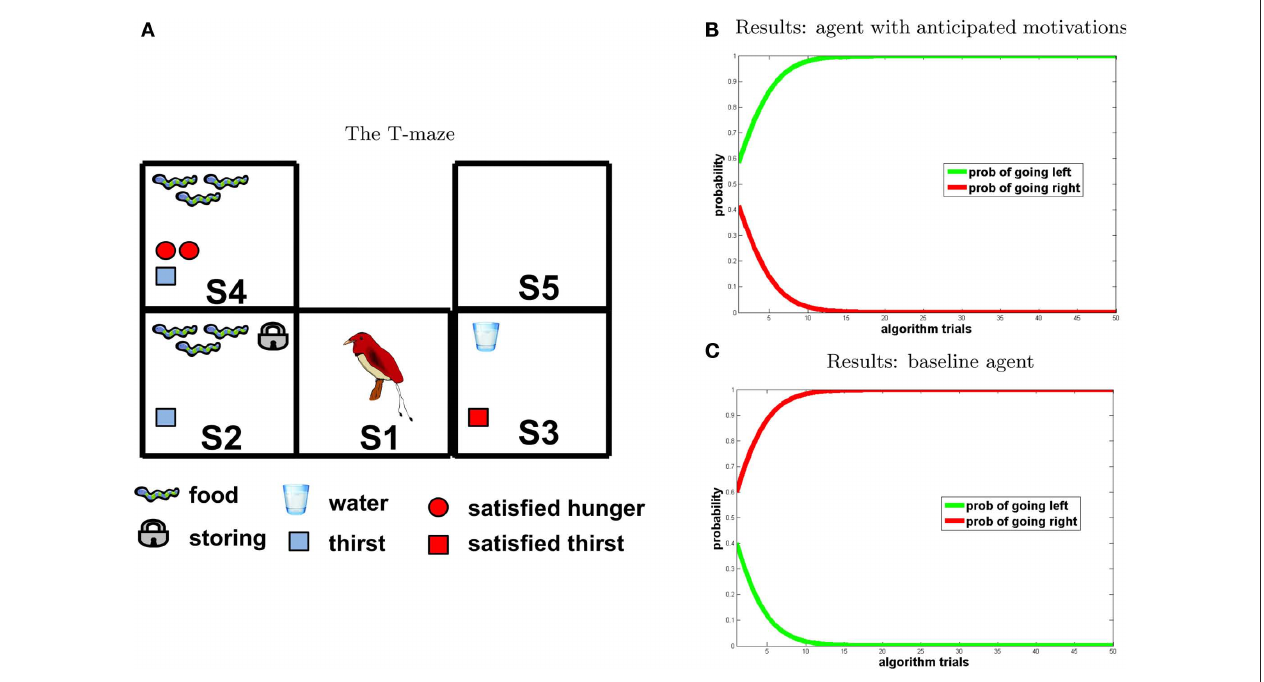
Figure 6 | experiment 3. (A) T-maze. (B,C) Results [ (A) agent with anticipated motivations; (B) baseline model], “going right” = red; “going left” =